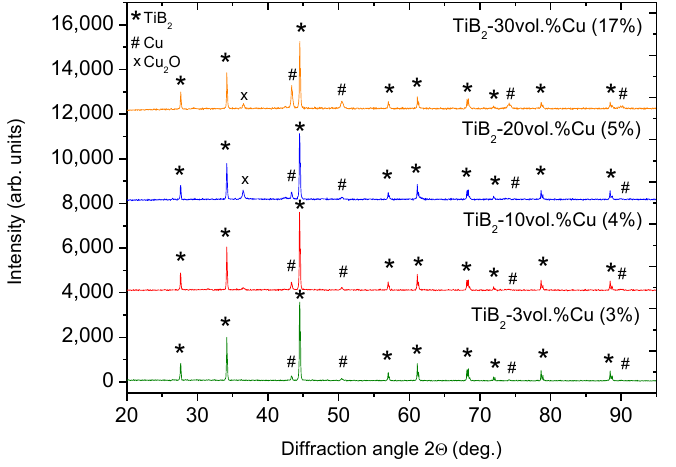
Figure 6. The X-ray diffraction (XRD) pattern for TiB 2 -Cu cermets sintered at 1100 °C for 20 min. The actual Cu contents after Spark Plasma Sintering (SPS) are indicated in parenthesis, after nominal